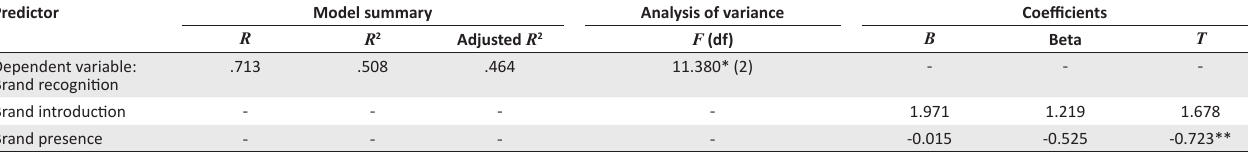
TABLE 2: Quadratic regression of brand recognition and brand presence. Predictor Model